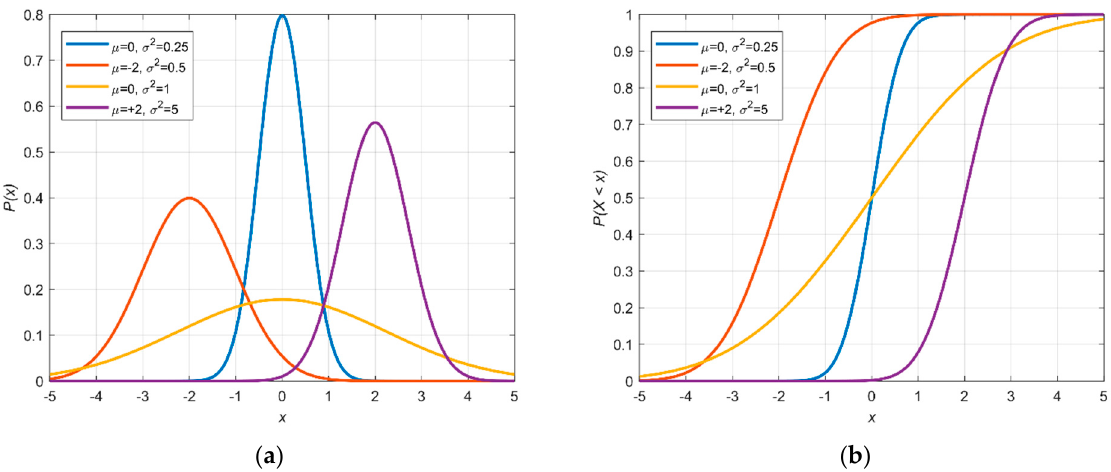
Figure A1. Normal (Gaussian) distribution: ( a ) Probability & ( b ) Cumulative Distribution Functions.